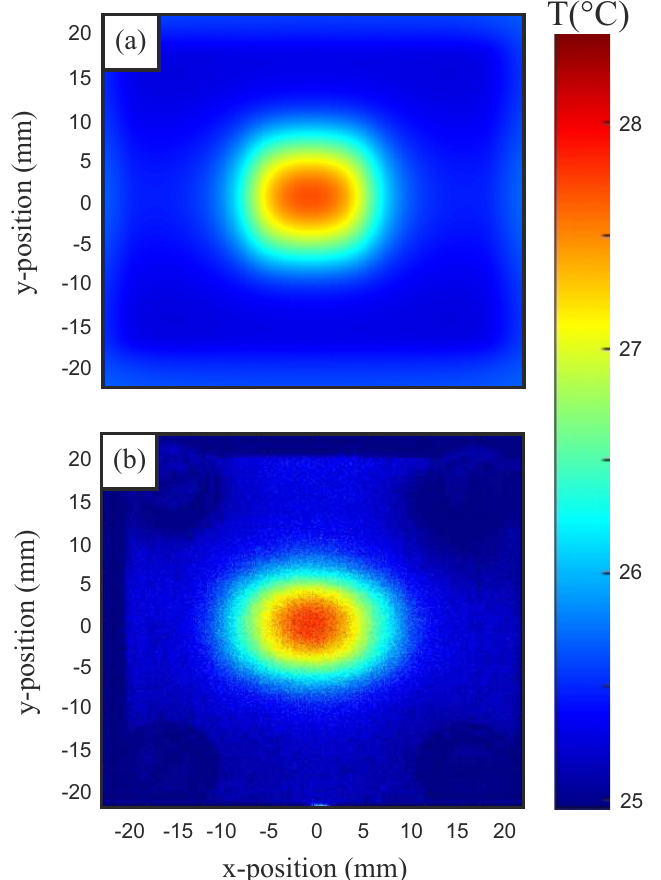
Figure 10. Thermography images of the investigated waveguide from ( a ) simulation and ( b ) thermal camera. Figure 11 shows the temperature distributions alongside the waveguide’s x-axis in comparison to a normalized cos 2 function. Both, simulation and measurement results, clearly reveal the expected field distribution. However, the simulation result fit the cos 2 - reference a little better. An explanation for this could be the combination of evanescent fields at the truncated waveguide flange as well as the neglected thermal conduction in